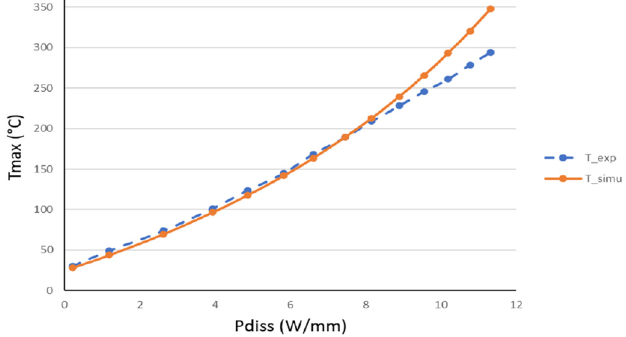
Fig. 3. Evolution of the HEMT maximum temperature.